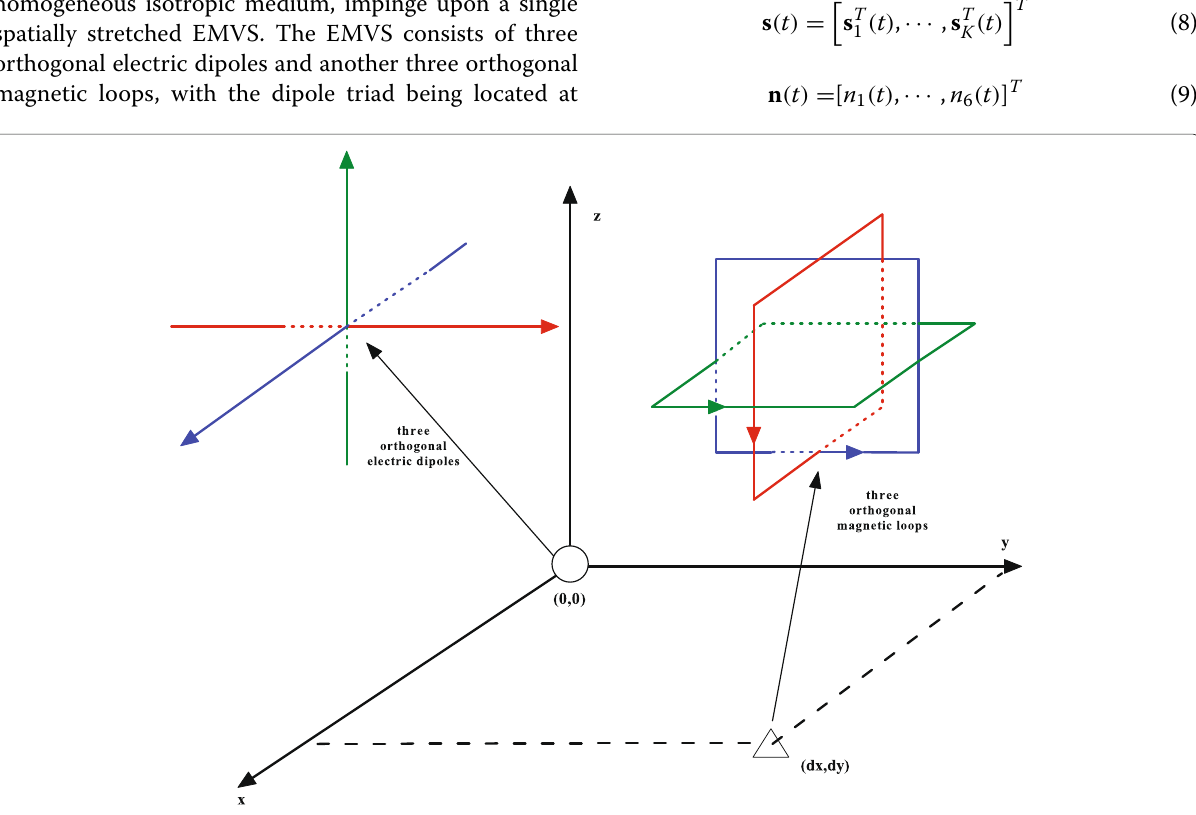
Fig. 1 Illustration of a spatially stretched